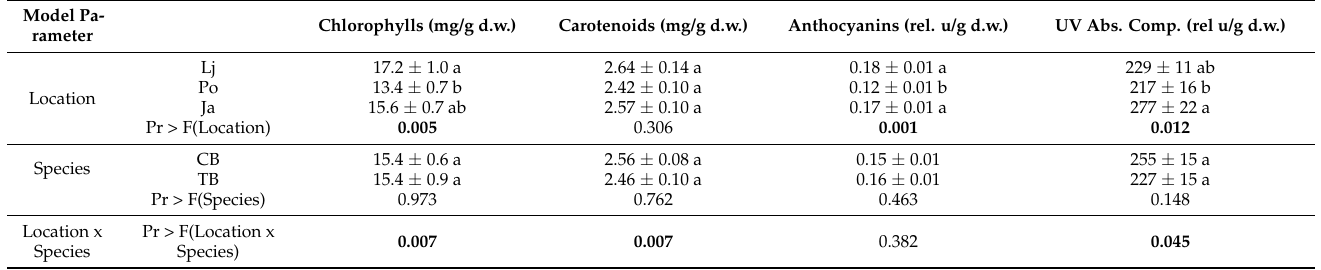
Table 2. Contents of chlorophylls, anthocyanins and UV-absorbing compounds in common and Tartary buckwheat plants, grown at different elevations.